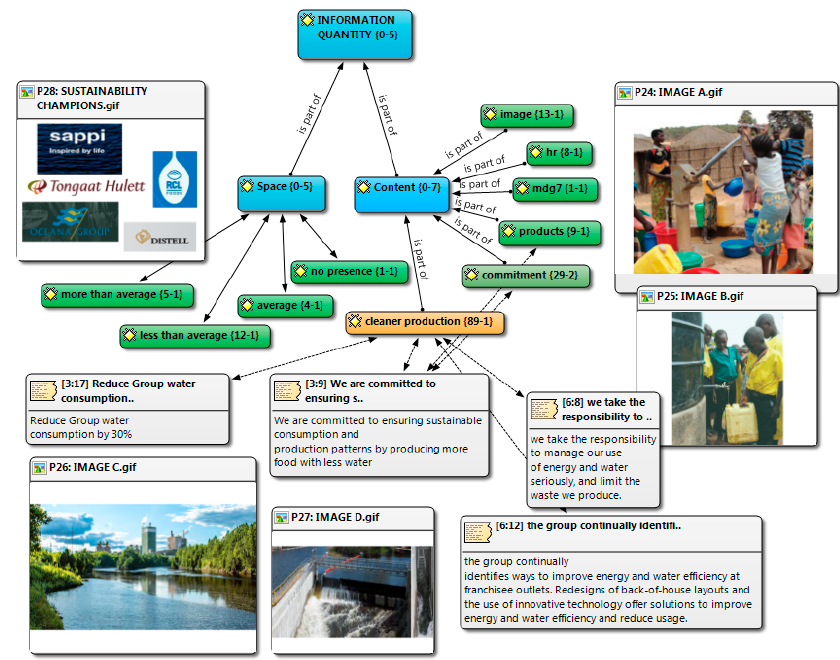
Figure 4. Information quantity (Source: Own work).